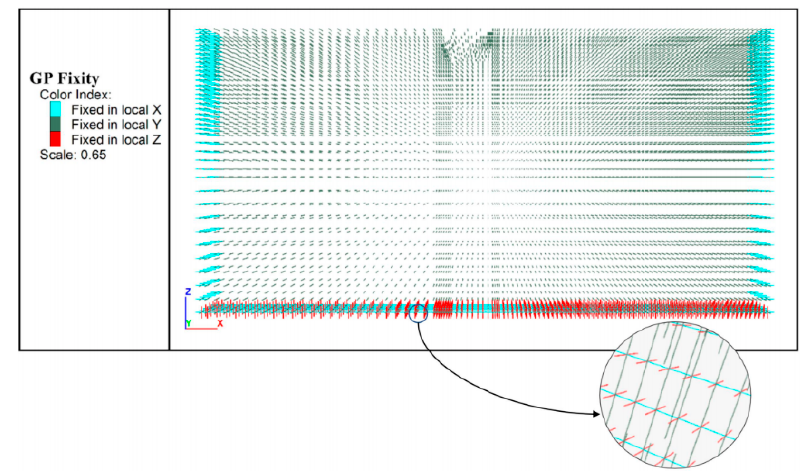
Figure 16. FLAC3D mesh model.